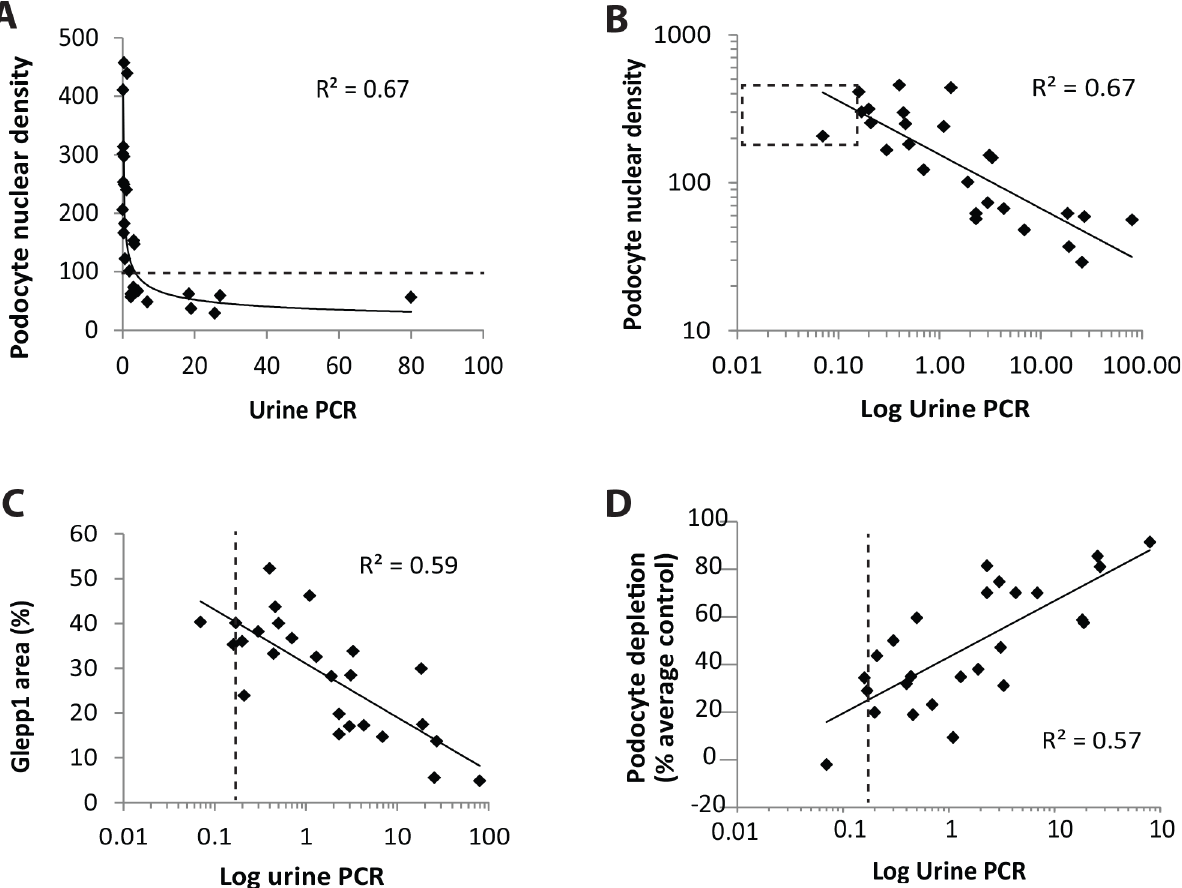
per 10 6 um 3 the level of proteinuria exponentially increases. Panel B: The same data as shown in Panel A except that proteinuria and podocyte density are shown on a log scale. The dotted box represents the mean ± 1SD for podocyte density and the upper limit of normal urine PCR at 0.18. Note that the log scale shows that proteinuria increases in proportion to reduction in podocyte density over a wide range. Panel C: Glepp1% area is an alternative way of measuring podocyte density also shows an exponential (log) relationship with proteinuria. Panel D: % podocyte depletion (calculated as a % of the normal age-matched mean level for each sample) shown in relation to log urine PCR demonstrating that at the upper limit of normal urine PCR (0.18) occurs when approximately 20% of podocytes have been lost. By the time the urine PCR has reached a value of 1 about 40% of podocytes have been lost. These data illustrate that low level proteinuria is a moderately early marker of podocyte depletion in ASC